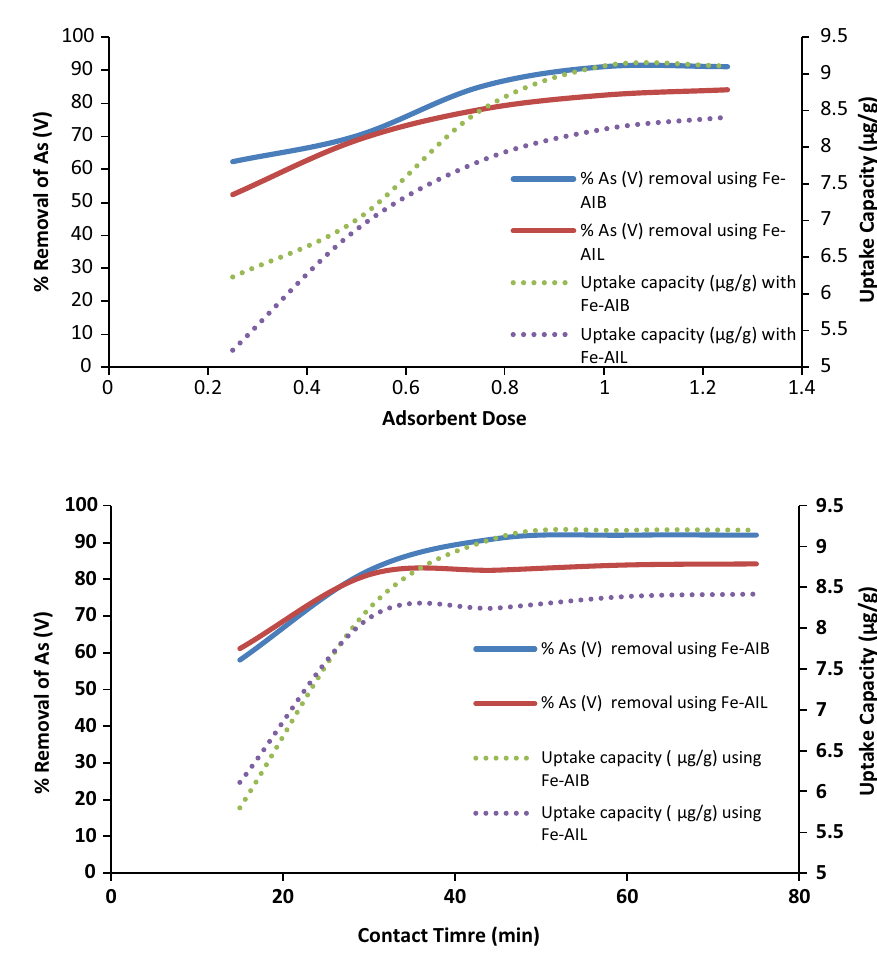
Fig. 9 Effect of adsorbent dose on adsorption of As (V) by Fe- AIB and Fe-AIL